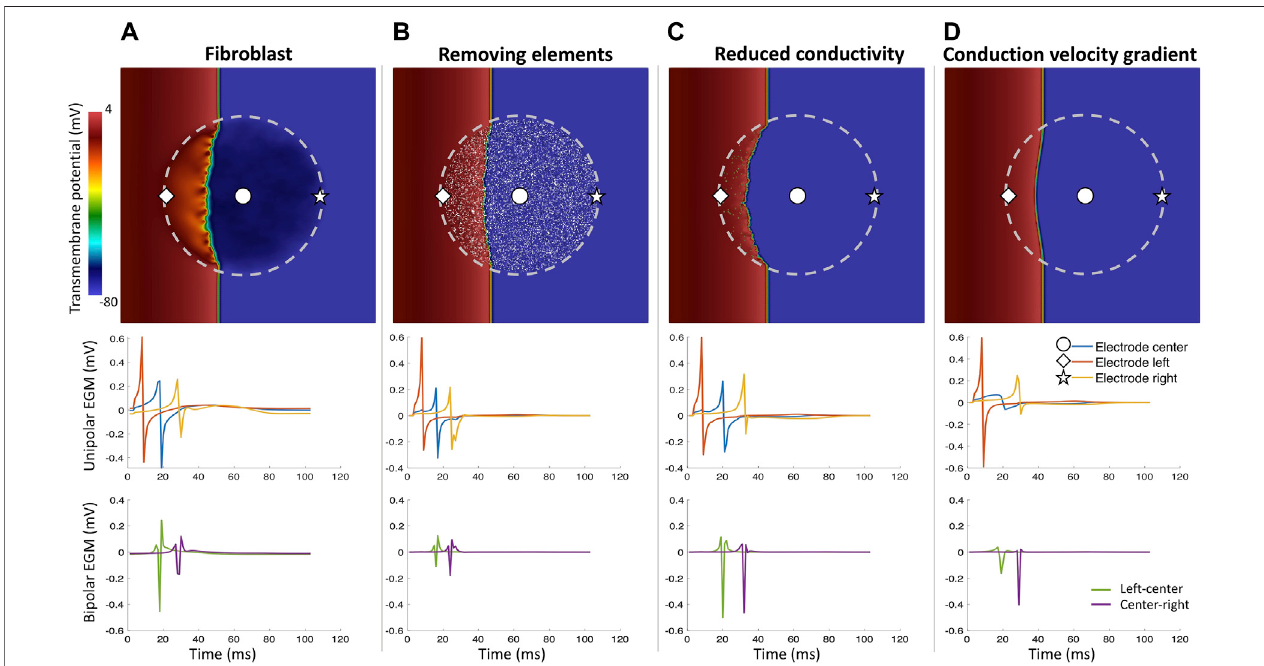
FIGURE 7 | Different fi brosis modeling methodologies and their corresponding unipolar and bipolar electrograms. Central fi brotic area (dashed line), the choice of themodelingapproachaffectstheresultinguEGMsandbiEGMs. (A) fi broblastscoupledtomyocytesinthe fi broticregion; (B) removingashareofelementsinthe fi brotic regionfrom the computationaldomain; (C) severelyreducingconductivityina share ofelements in the fi brotic region but the spatial transmembranevoltage gradients of fi broticelementsstillcontributetotheEGMs; (D) conductivitygradientfromcenterofthe fi broticregiontothesurroundinghealthytissue.AbsoluteEGMamplitudes are smaller than in vivo due to the small size of the tissue